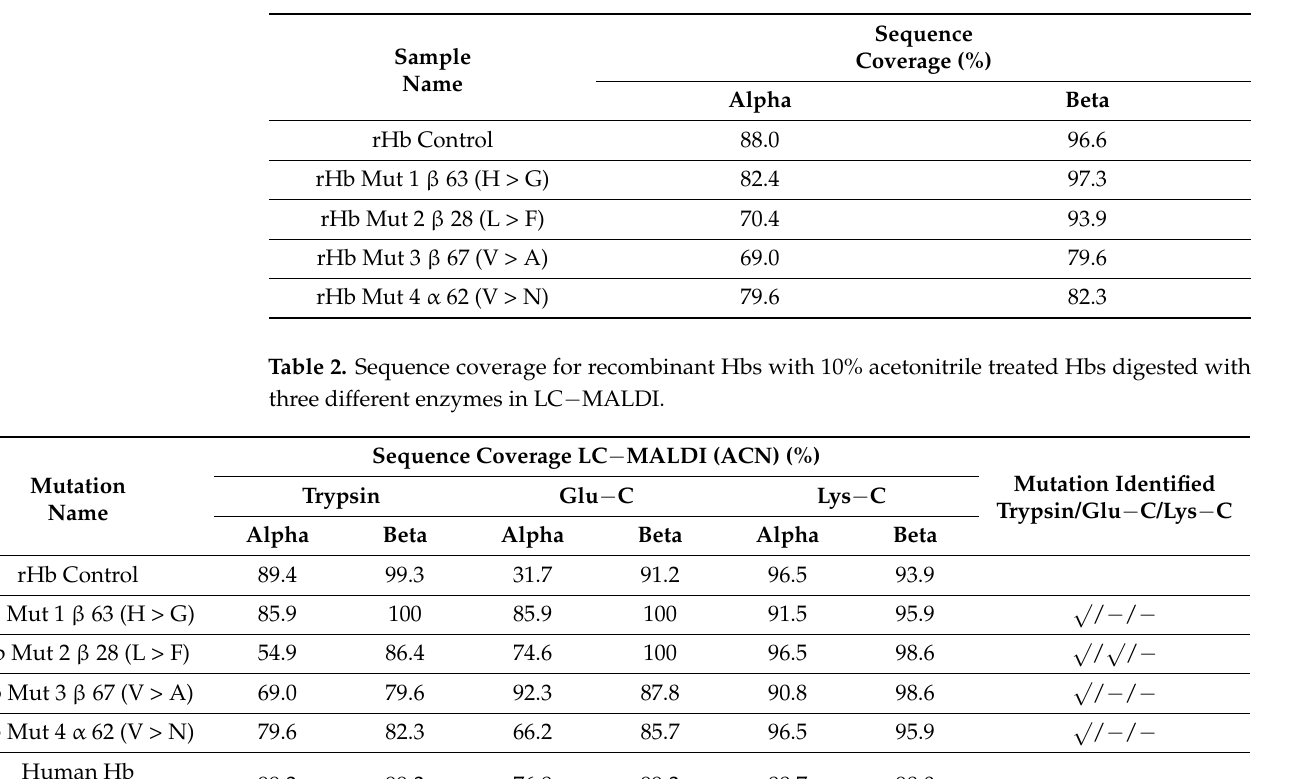
Table 1. Sequence coverage for 10% acetonitrile treated recombinant Hbs (rHbs) in LC − MALDI.